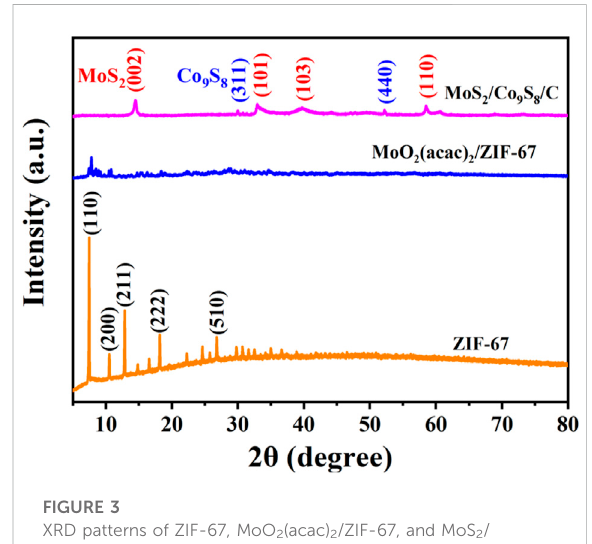
FIGURE 3 XRD patterns of ZIF-67, MoO 2 (acac) 2 /ZIF-67, and MoS 2 / Co 9 S 8 /C